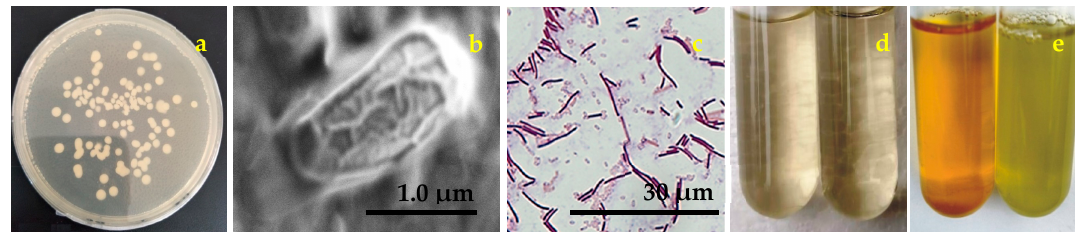
Figure 2. Characterization of Bacillus subtilis J2 bacteria. ( a ) A single colony on the solid plate; ( b ) the morphology in SEM view; ( c ) the Gram staining in a biological microscope view; ( d ) the sample before adding the Nessler’s reagent; ( e ) the sample after adding the Nessler’s reagent. In Figure 2d,e, the left is the experimental group inoculated with bacteria and the right is the control group without